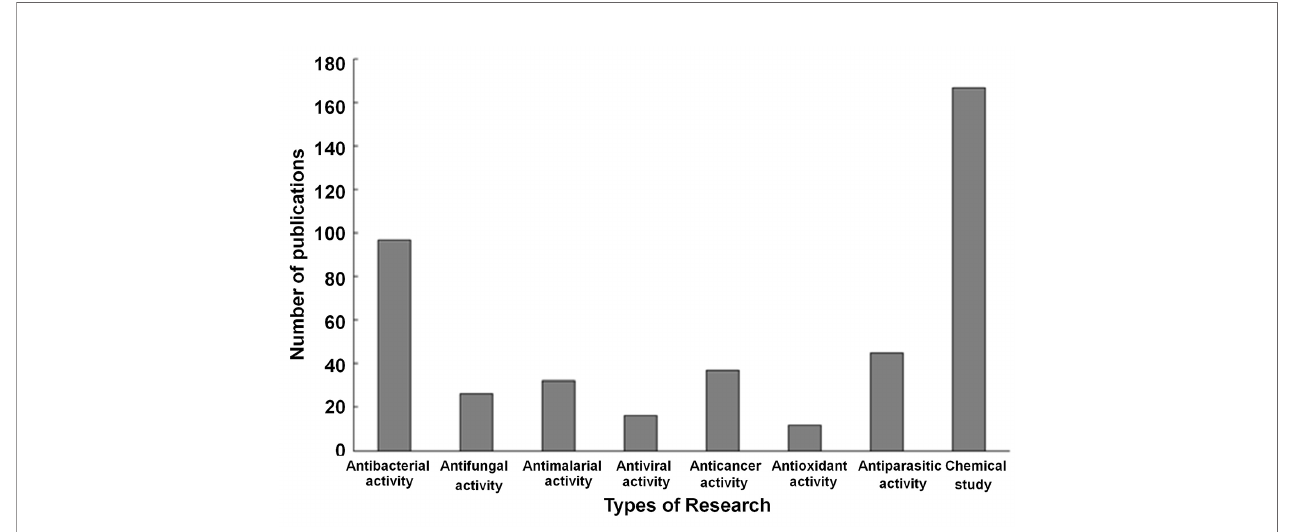
FIGURE 3 | Trends in Terminalia sp. research within 2010-2020. The information was collected from PubMed (https://pubmed.ncbi.nlm.nih.gov/?term=Terminalia +sp.& fi lter=ds1.y_10, 15 July